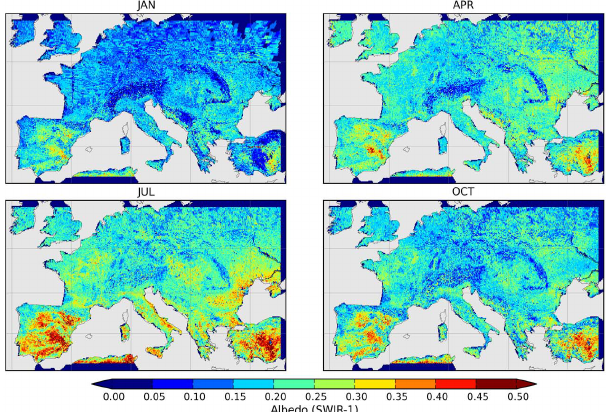
Figure 5. Lambertian surface albedo adopted for the European trial ensemble in the SWIR-1 channel (at 1640nm) for the months Jan- uary (JAN), April (APR), July (JUL), and October